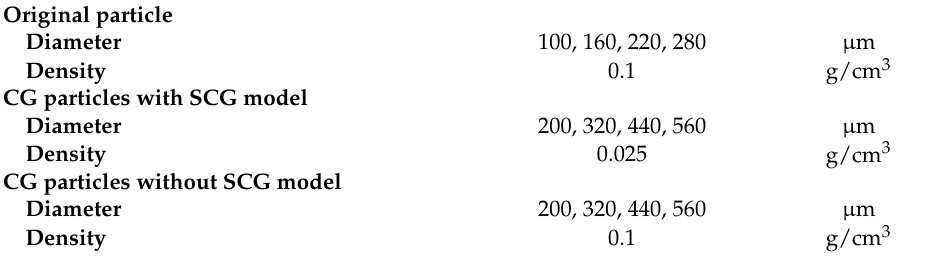
Table 3. Simulation conditions for particles in the